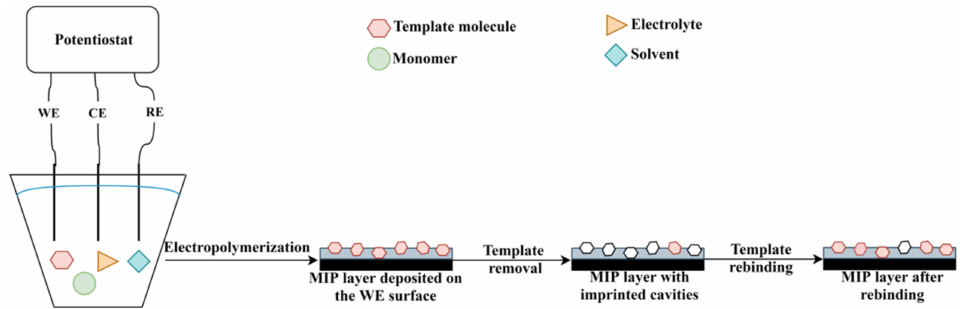
Figure 4. The principle of MIP deposition by